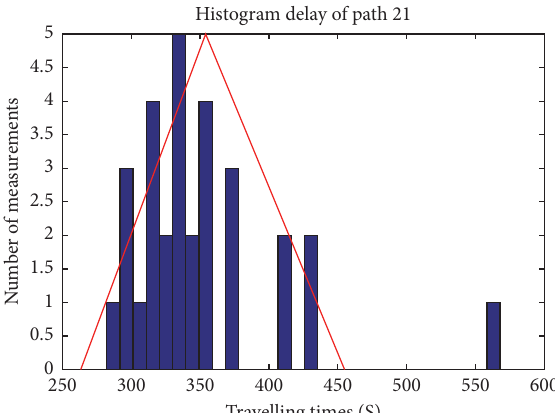
Figure 7: Triangular PDF of the travelling time between the Mahdia and Faculty stations (Mahdia to Sousse direction).